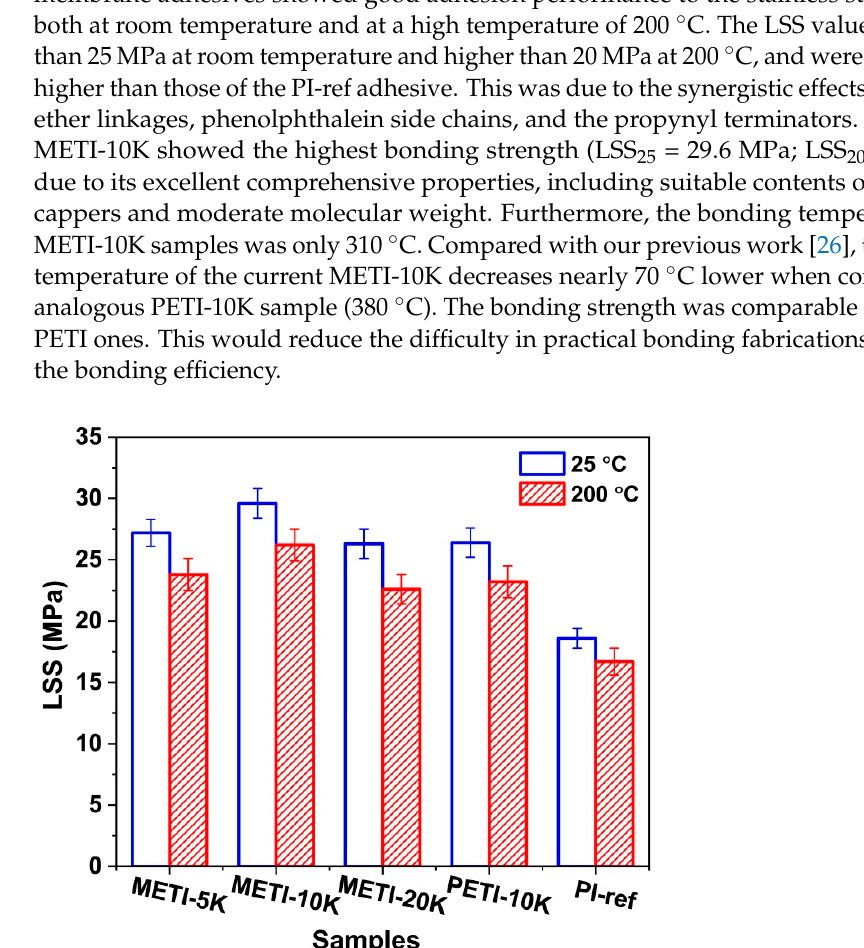
Figure 11. SEM images of METI-20K NFM after hot-pressing treatment. ( a ) 500×; ( b ) 4000×.